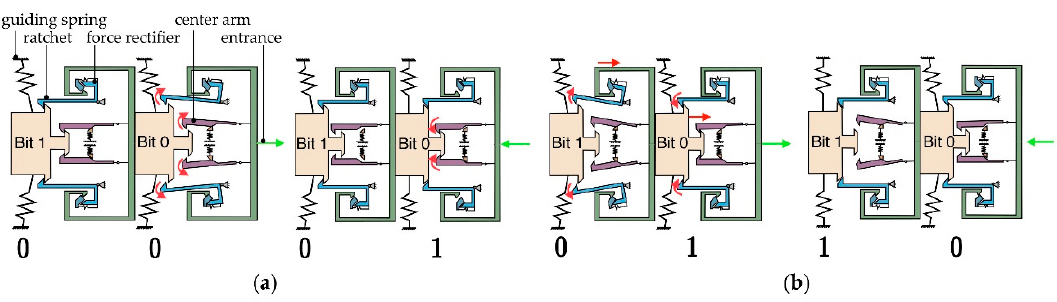
Figure 2. Schematic explanation showing the mechanical state transition when applying a mechanical impulse at the entrance: ( a ) transition from 0-0 to 0-1; ( b ) transition from 0-1 to